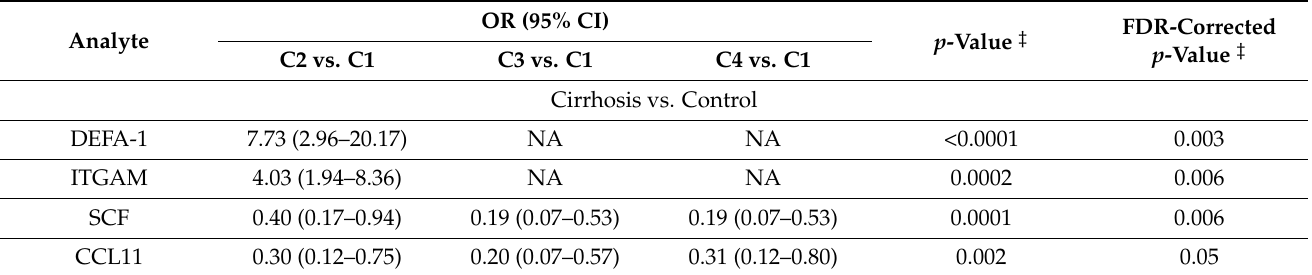
Table 2. Odds ratios * and 95% confidence intervals [Cis] for associations between selected markers and cirrhosis versus non-cirrhotic controls.